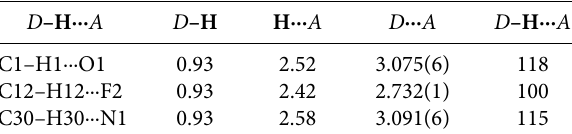
Table 3. Hydrogen bonding arrangements for complex 2b · H 2 O (Å, °).